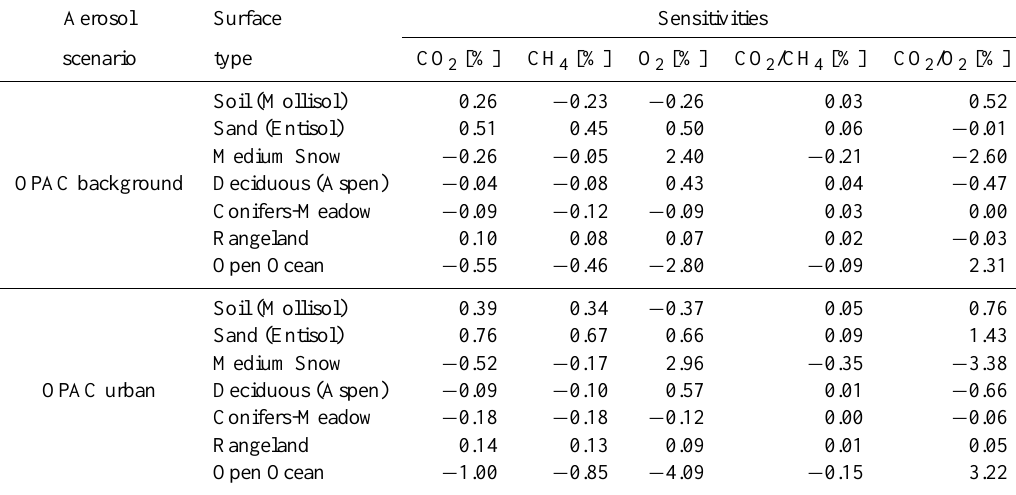
Table 5. Sensitivity to surface spectral albedo (surface type) reproduced from the ASTER Spectral Library through the courtesy of the Jet Propulsion Laboratory, California Institute of Technology, Pasadena, California (©1999, California Institute of Technology) and the Digital Spectral Library 06 of the US Geological Survey in the same form as used by Reuter et al. (2010). Assumed solar zenith angle was 40 ◦ and the aircraft altitude was